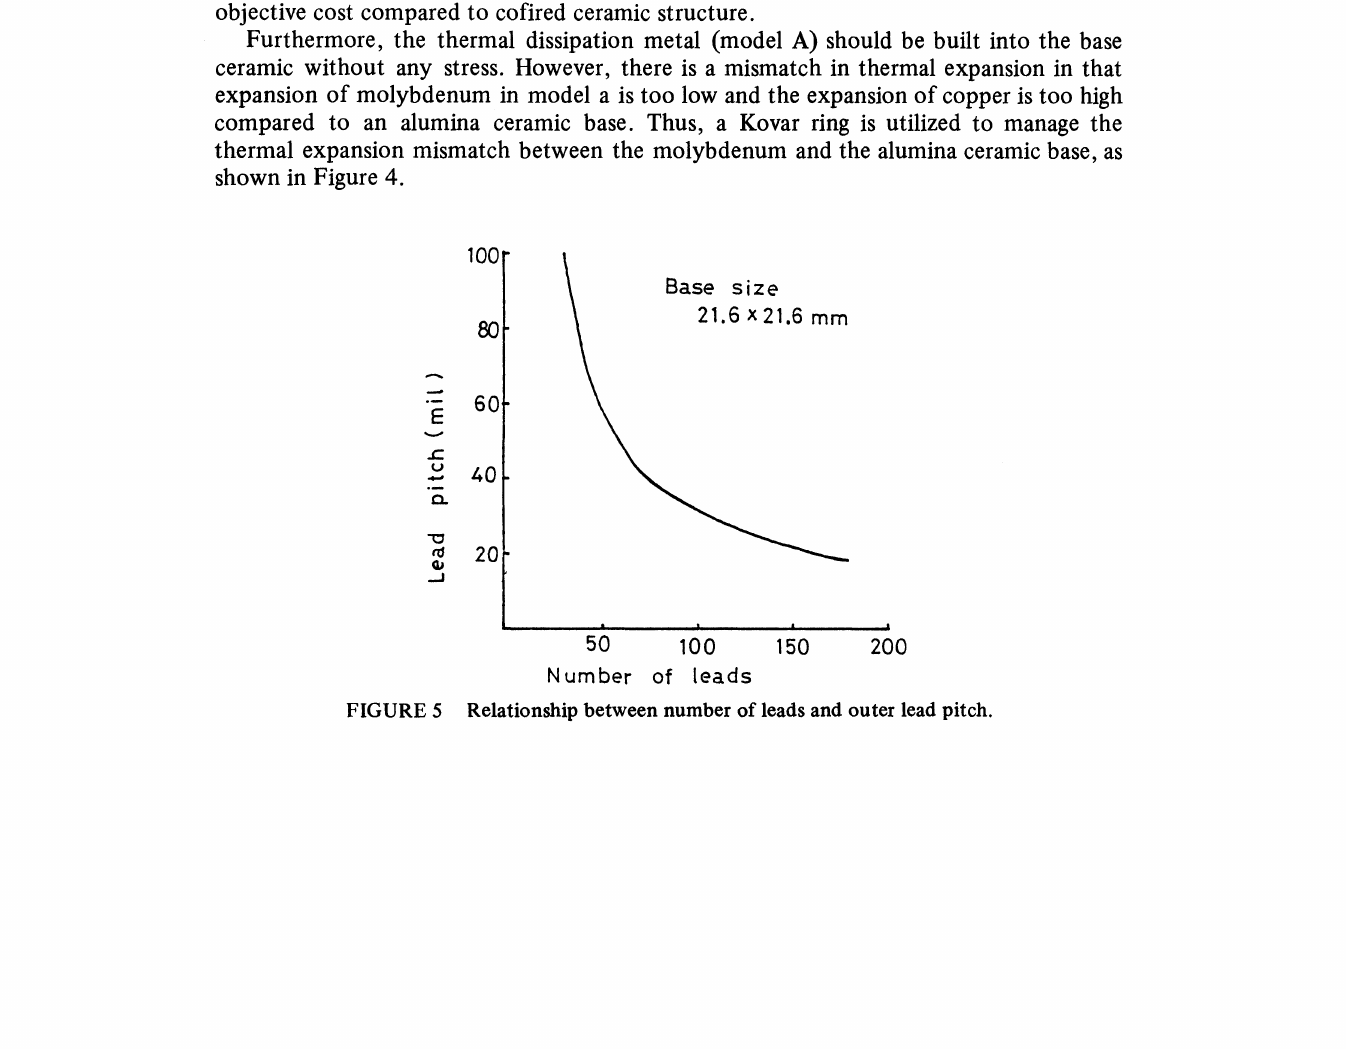
Number of leads FIGURE 5 Relationship between number of leads and outer lead